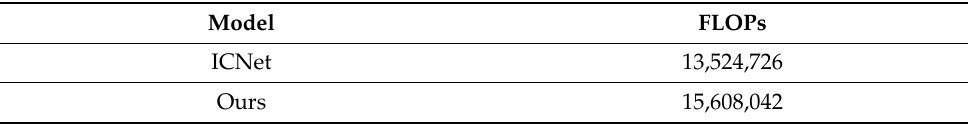
Table 3. Comparison of calculations before and after ICNet